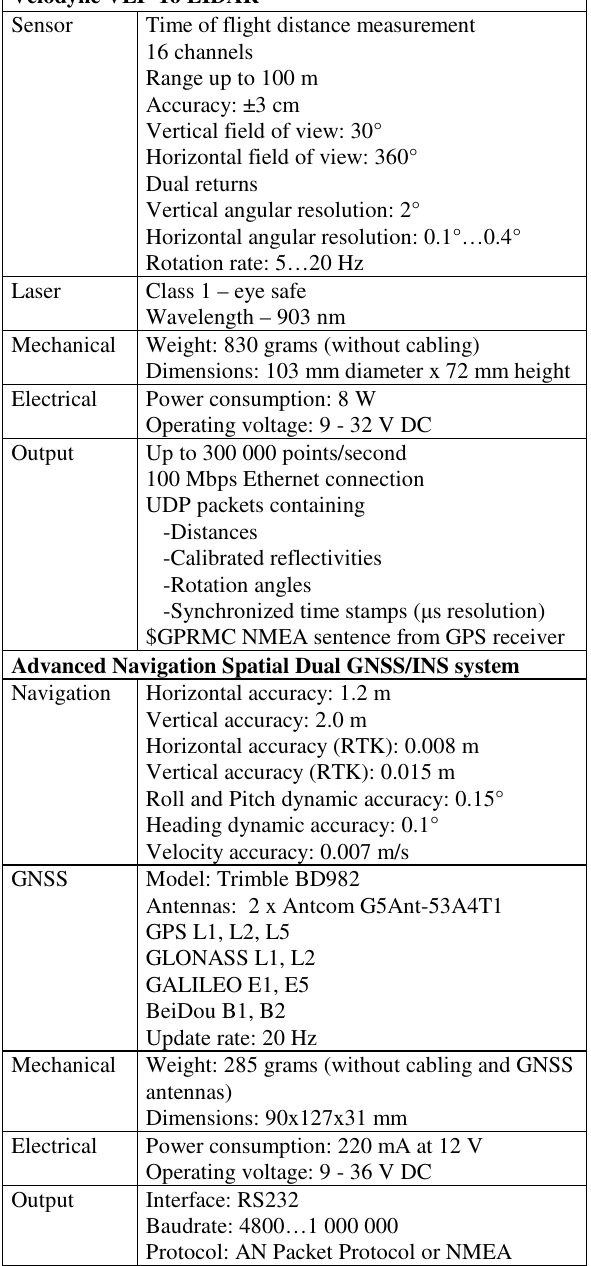
Table 1. Velodyne VLP-16 and Advanced Navigation